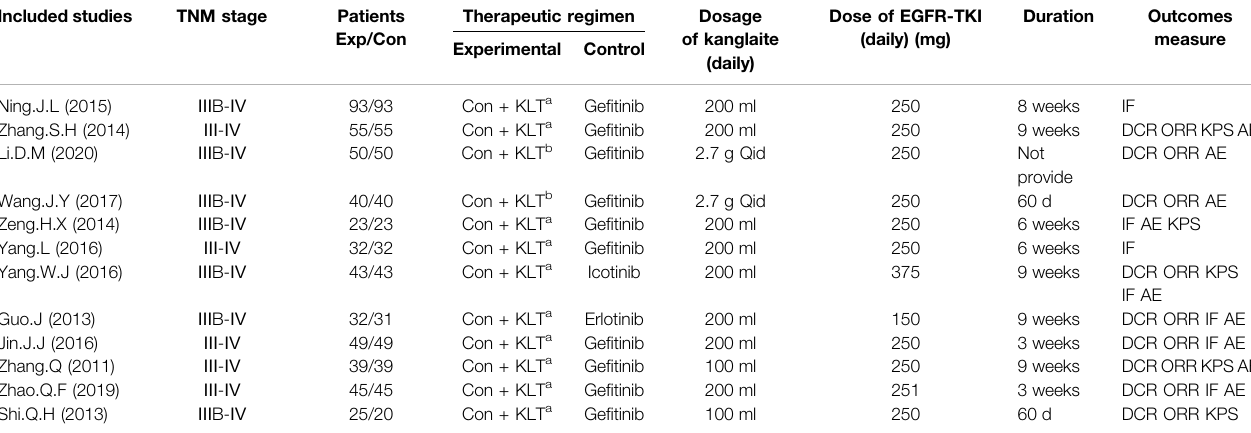
TABLE 1 | Clinical information from the eligible trials included in the meta-analysis. Included studies